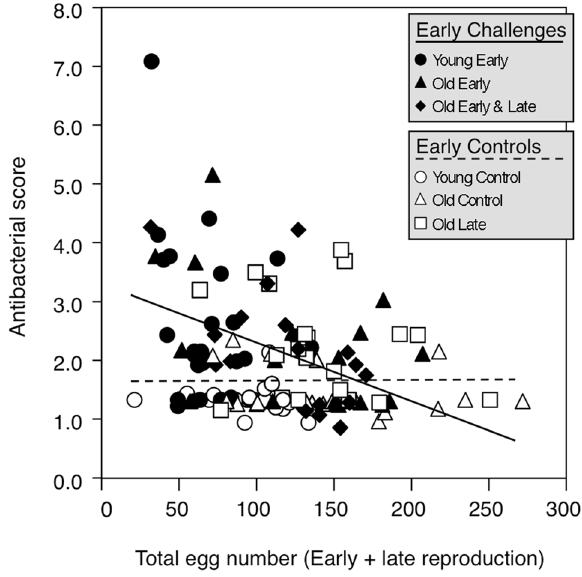
Figure 4. Variation in scores of inducible antibacterial defence as a function of total fecundity (number of eggs laid) the early-life immune treatment. The negative relationship between antibacterial scores and fecundity is significant only among females that were exposed to an early immune challenge (continuous line: F 1, 62 = 11.77, P = 0.001, r = 0.4). Among controls, the relationship is not statistically significant, and the dashed line is illustrative